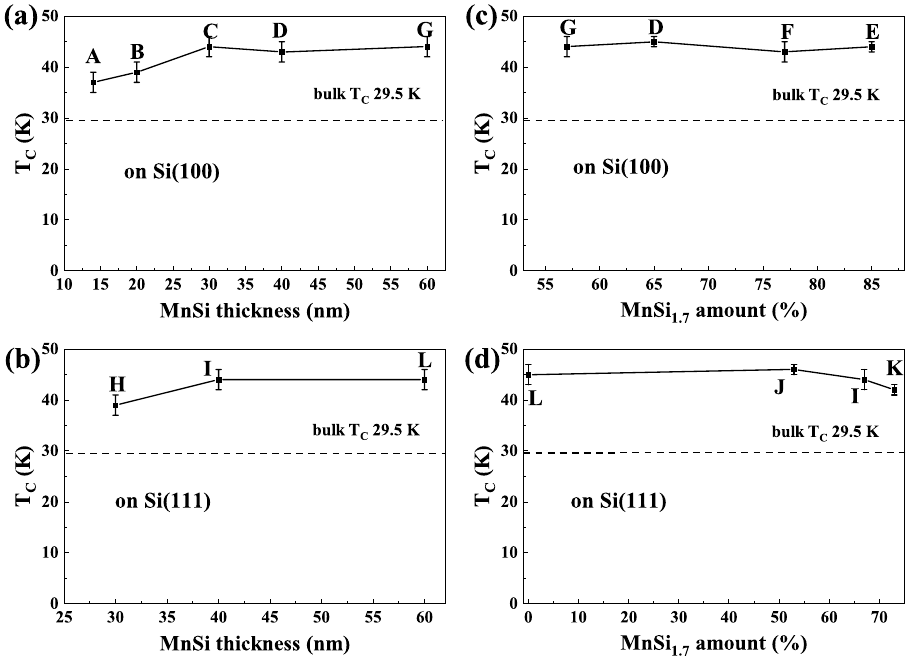
Figure 3. Curie temperature as a function of the thickness of MnSi films on ( a ) Si(100) substrates and Si(111) substrates ( b ). Curie temperature as a function of the content of MnSi 1.7 phase on ( c ) Si(100) substrates and Si(111) substrates ( d ). All these samples have approximately the same Curie temperature of 43 K, which is larger than that of bulk MnSi. The sample ID is indicated in the figures around the corresponding data